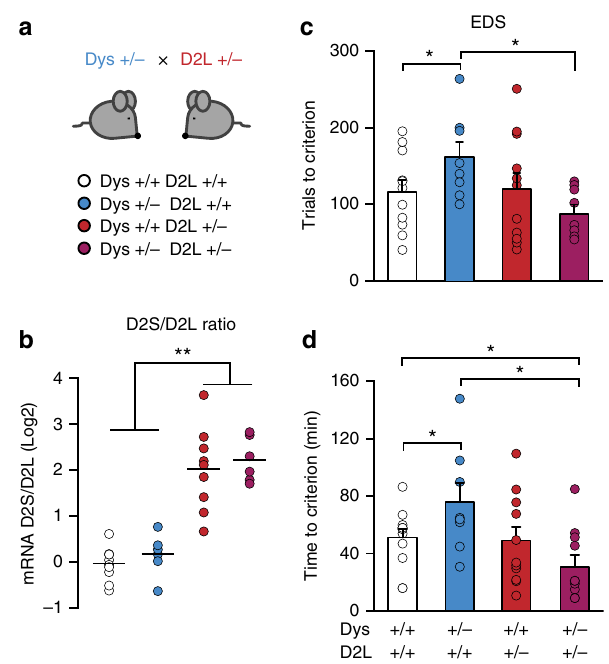
Fig. 7 Altering the D2S/D2L ratio in favor of D2S improves executive functions exclusively in mice with genetic reduction of dysbindin-1. a Dys + / − D2L + / − double mutant mice (magenta bar), single Dys + / − (blue bar), single D2L + / − (red bar) and wild-type (white bar) littermates were generated by mating double heterozygous males with naive C57 female mice. b D2S/D2L ratio was increased in the mPFC of D2L single mutant (Dys + / + D2L + / − ) and Dys + / − D2L + / − double mutant mice compared to wild-type controls ( n = 6 – 10 each group; one-way ANOVA, F (3, 29) = 10.44, p < 0.0005). c Dys + /-D2L + /- double mutant mice needed less trials to solve the EDS compared to Dys + / − mice (unpaired t -test, t = 3.13, df = 13, p < 0.05 n = 8 – 12 each group. One-way ANOVA, F (3, 33) = 2.30, p = 0.09). d Dys + /-D2L + /- double mutant mice completed the EDS in less time compared to Dys + / − single mutant mice and wild-type controls (one-way ANOVA, F (3, 36) = 3.64, p < 0.05; n = 8 – 12 each group). Error bars represent S.E.M. * p < 0.05, ** p <